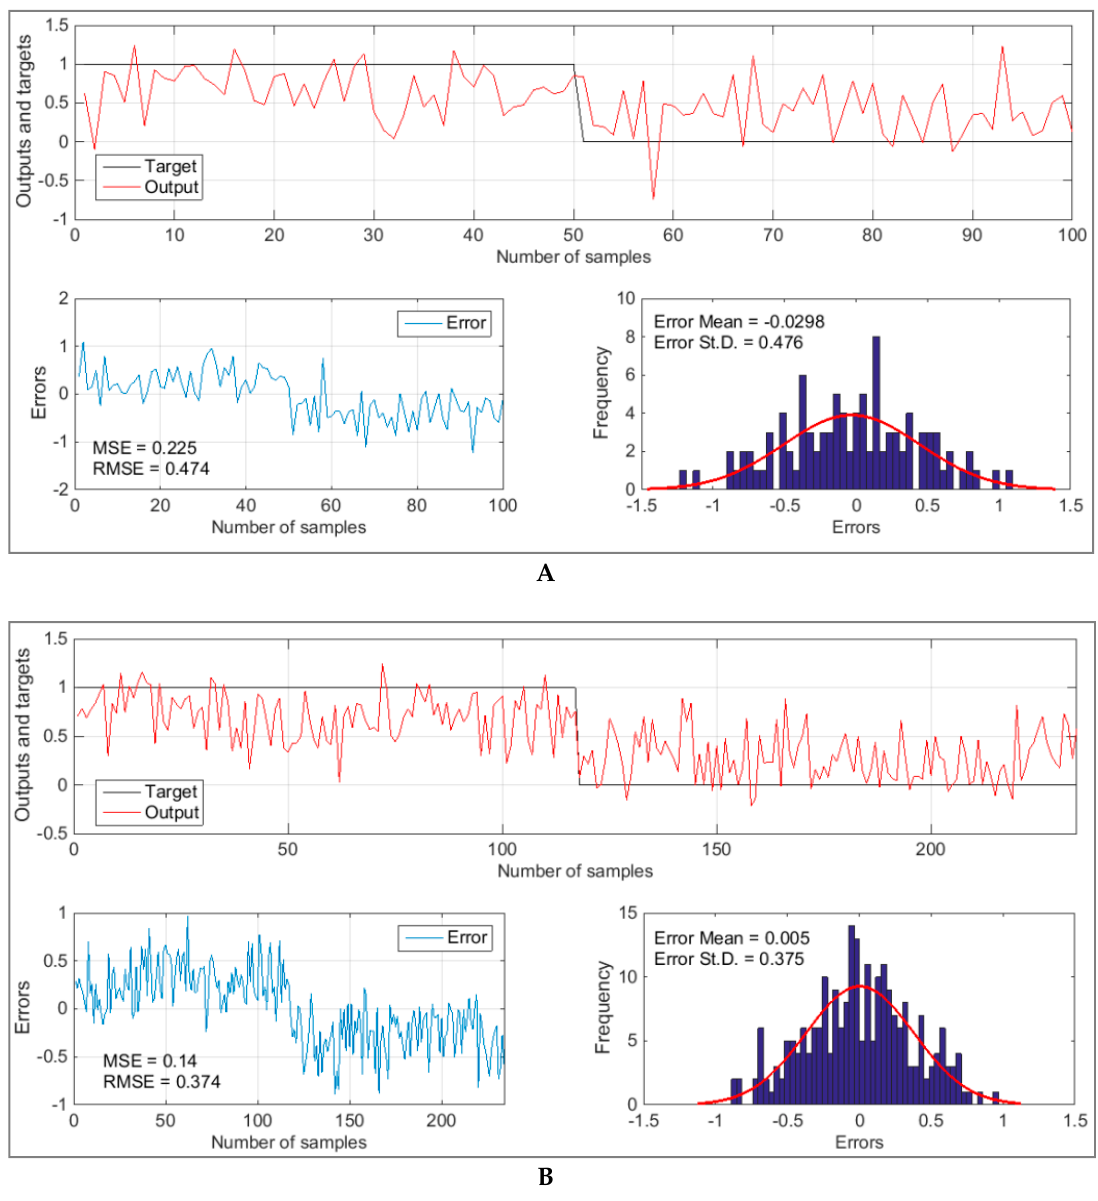
Figure 8. Analysis of errors of the PSOANFIS model using ( A ) the training dataset and ( B ) the validating dataset.